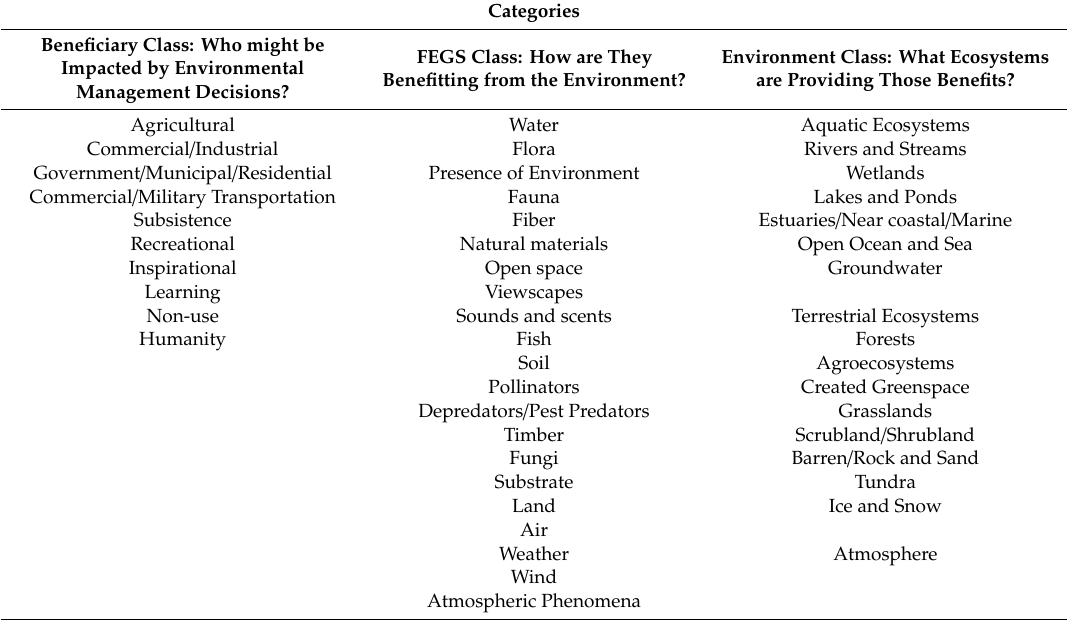
Table 1. Categories of Environments, Beneficiaries, and Final Ecosystem Goods and Services (FEGS) in the FEGS Classification System (FEGS-CS) (from [11]), and example questions to identify